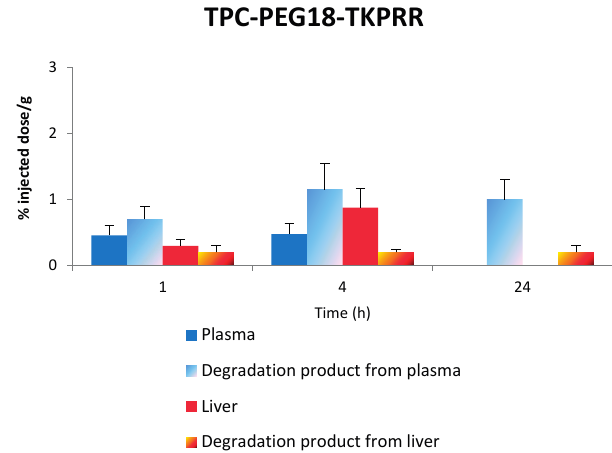
Figure 10. The concentration of the respective conjugates in the plasma and liver along with the concentration of degradation products in both plasma and liver at 1, 4 and 24 h.